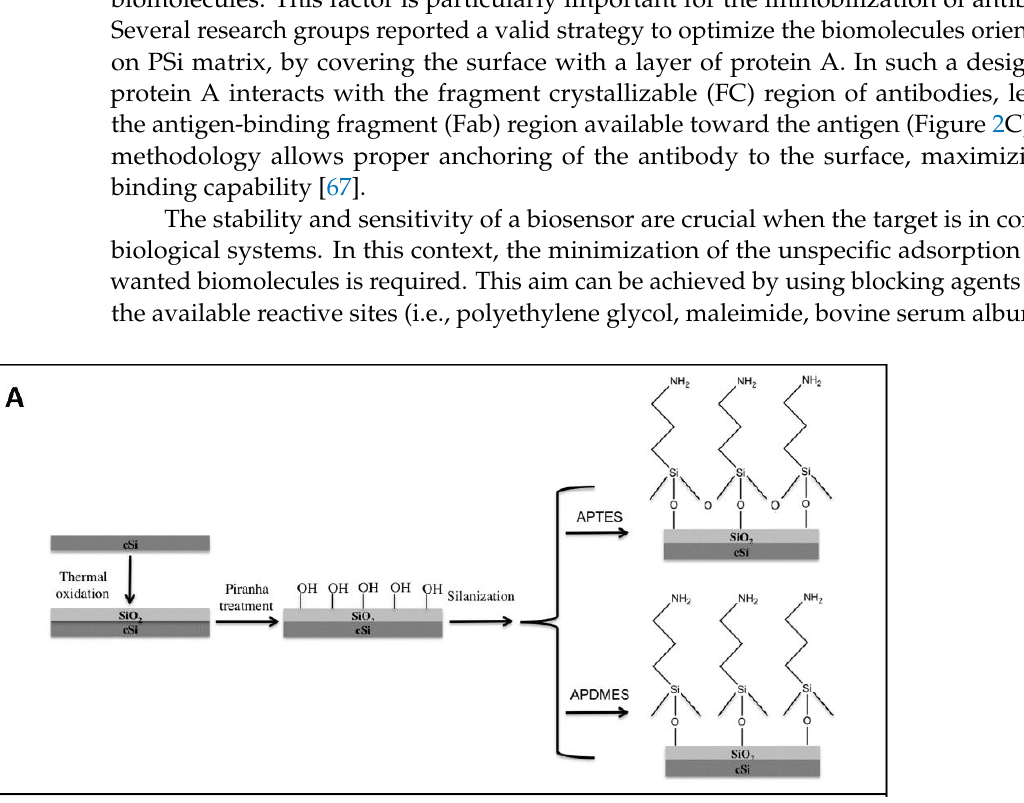
Figure 2. ( A ) Scheme of PSi functionalization through thermal oxidation and silanization with APTES or APDMES. Reprinted with permission from Reference [60]. ( B ) (a) Scheme of oxidized porous silicon modified through a ring-opening click reaction; (b) structure of reagents used for the study—thia-silane (DMTSCP, 2,2-dimethoxy-1-thia-2-silacyclopentane), butyl-aza-silane (BADMSCP, N - n -butyl-aza-2,2-dimethoxy-silacyclopentane), diaza-silane (DMDASCP, 2,2-di- methoxy-1,6-diaza-2-silacyclooctane), and methyl-aza-silane (MATMSCP, N -methyl-aza-2,2,4- trimethyl-silacyclopentane). R 1 = OMe, Me. R 2 = H, Me. Reprinted with permission from Reference [65] https://pubs.acs.org/doi/10.1021/jacs.6b08614 (accessed on 16 December 2020). Copyright (2016) American Chemical Society. ( C ) (a) Cartoons of randomly immobilized antibodies via phys- ical adsorption and (b) properly orientated on the PSi matrix by using an intermediate layer of Protein A. Reprinted with permission from Reference [67] https://creativecommons.org/li- censes/by/4.0/ (accessed on 16 December 2020). 3. PSi Optical Transducer for Biosensors Development The PSi structure is by far one of the most fascinating materials for the construction of a variety of biosensors, due to its optical, electrical, and chemical properties. To date,